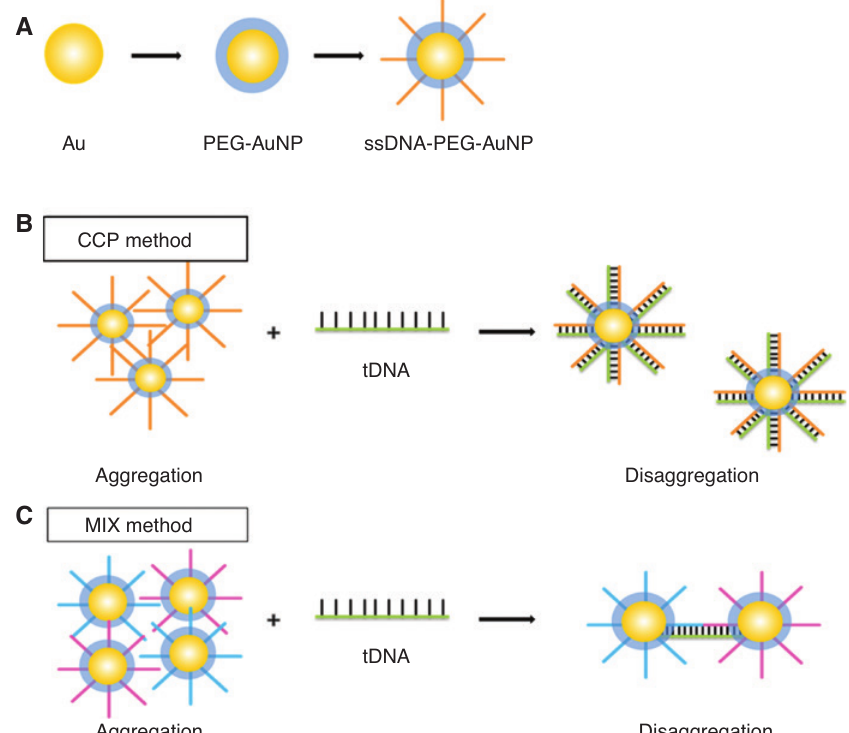
Figure 1: The schemes for the tDNA detection. (A) The colloidal gold nanoparticles (AuNPs) are encoded with low molecular weight polyethylene glycols (PEG) and functionalized with thiolated DNA capture probes (ccpDNA, hcpDNA-1 or hcpDNA-2). (B) The CCP detection method with the complete capture probe (ccpDNA) grafted at the gold nanoparticle surface: the disaggregation of the NPs is induced by the direct binding between the ccpDNA and the target DNA (tDNA). (C) The MIX method using both the half-capture probes (hcpDNA-1 and hcpDNA-2) grafted separately on different NPs: the disaggregation of the NPs is induced by one tDNA molecule binding to two NPs. Each gold particle contains about half complementation bases of the tDNA.